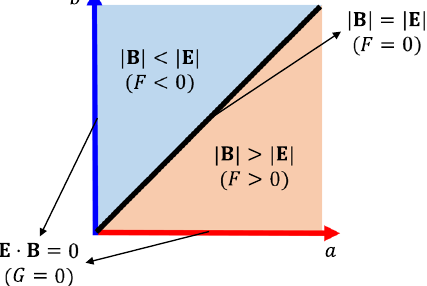
(cid:7) (cid:6) / 2 = 0). B 2 − E 2